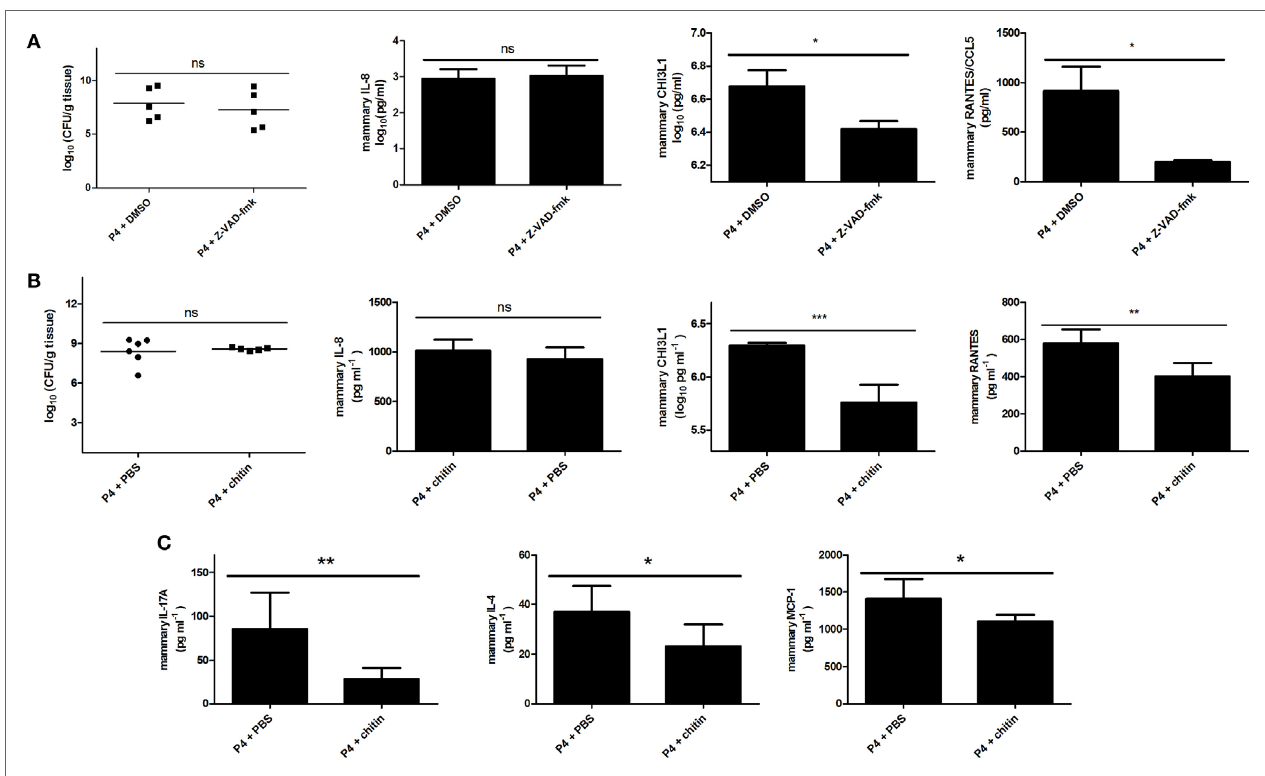
FigUre 4 | Upstream regulators of mammary chitinase 3-like 1 (CHI3L1) during Escherichia coli P4 infections in the mouse mastitis model. (a) Bacterial loads ( n = 5), and interleukin (IL)-8 ( n = 5), CHI3L1 ( n ≥ 4), and RANTES/CCL5 levels ( n = 5) in the E. coli P4-infected mammary glands of mice treated with Z-VAD-fmk or DMSO (sham) at 24 h p.i. (b) Bacterial loads ( n ≥ 12), and IL-8 ( n ≥ 8), CHI3L1 ( n = 6), and RANTES/CCL5 levels ( n = 6) in the mammary gland of mice treated with chitin or phosphate buffered saline (PBS) controls at 24 h p.i. with E. coli P4. (c) IL-17A ( n = 6), IL-4 ( n = 6), and MCP-1 levels ( n = 6) in the E. coli P4-infected mammary gland of mice treated with chitin or PBS controls at 24 h p.i. Data are presented as means ± SEM, indicating significant differences with *( P < 0.05); **( P < 0.01); or ***( P < 0.001). ns, not